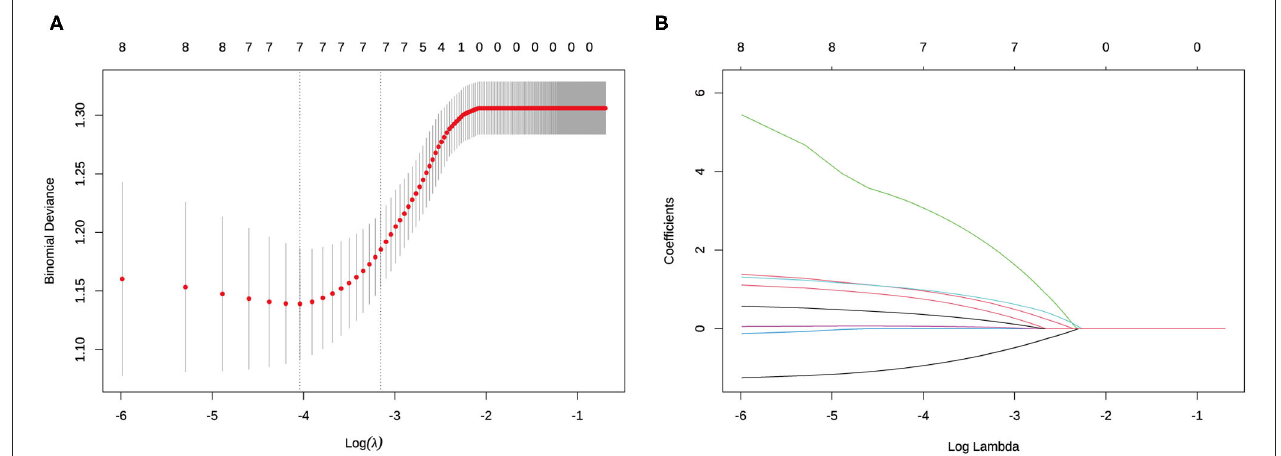
FIGURE 2 | Determination of the risk factors of cervical lymph node metastasis (CLNM) in clinically node-negative (cN0) unilateral papillary thyroid microcarcinoma (PTMC) patients by least absolute shrinkage and selection operator (LASSO) regression analysis. (A) LASSO regression analysis of the risk factors identified by univariant logistic regression analysis. (B) Coefficients of the risk factors in LASSO regression